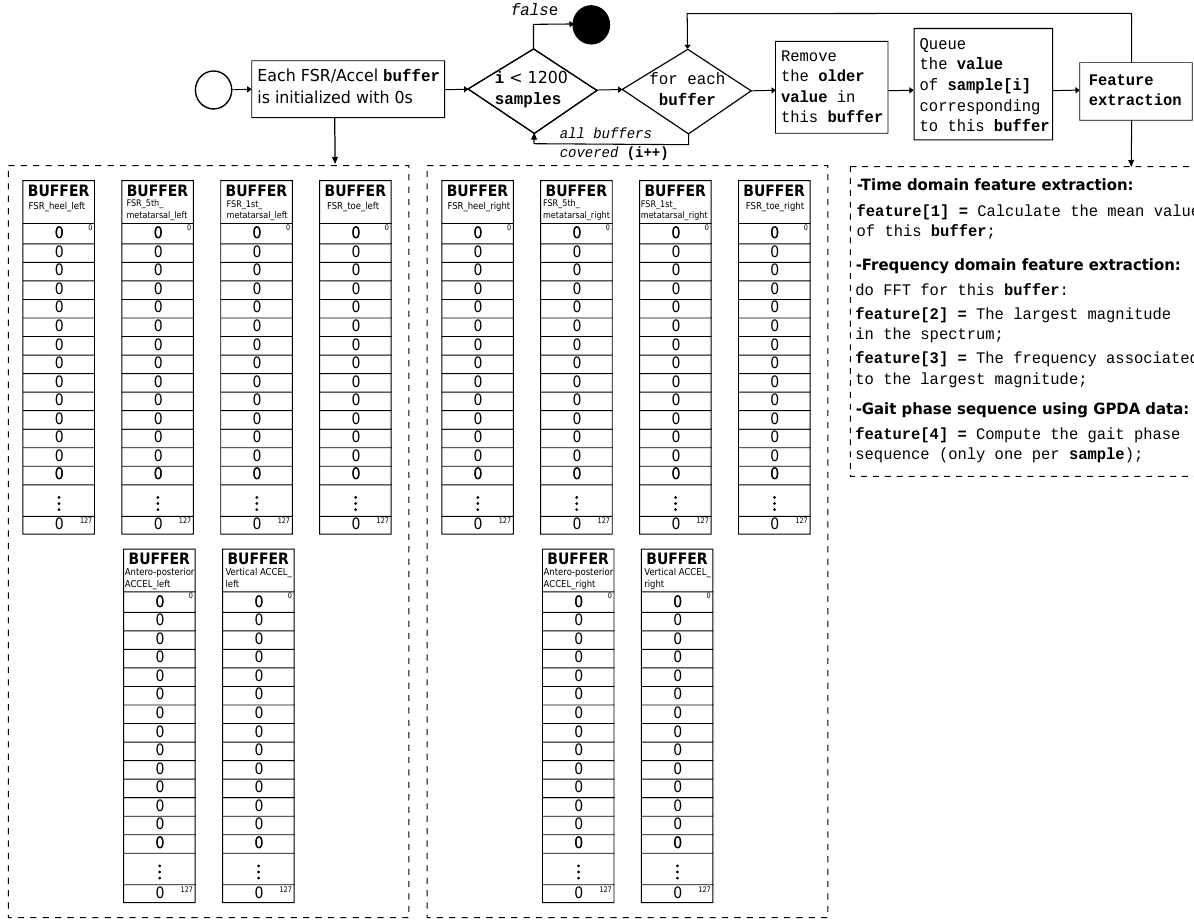
Figure 6. Feature extraction for each low-level activity (set of 1200